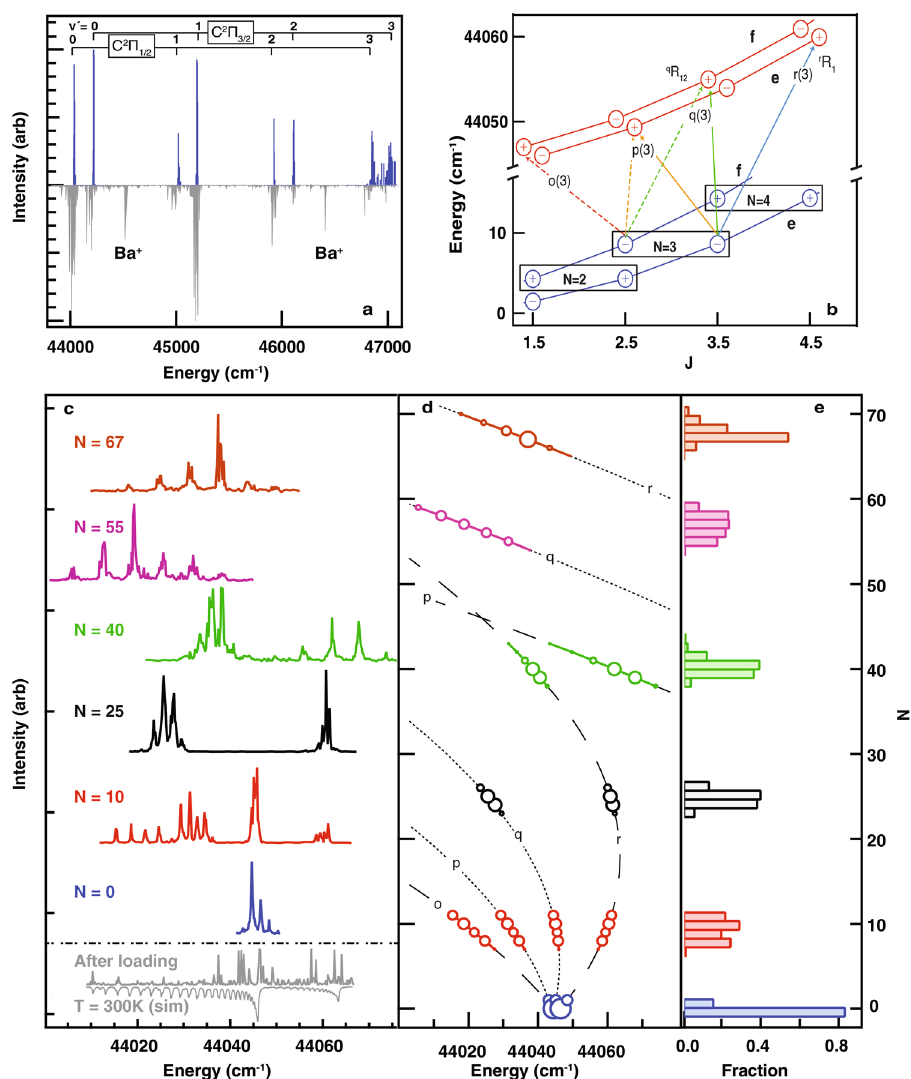
Fig. 2 Super rotor spectra. a Low-resolution survey spectrum of C 2 Π – X 2 Σ + transition of SiO + , before (lower) and after (upper) pumping toward N = 0. Two contaminating Ba + lines are present. The v ′ = 3 lines are expected to be broadened because of near-threshold predissociation, but these spectra are not yet fully understood. b Rotational fi ne structure of the C 2 Π 1/2 – X 2 Σ + transition (see Supplementary Information Section 1 for notation). c High- resolution spectra before and after pumping toward various N . The hot unpumped spectrum shows the sample is not yet thermalized to 300 K when pumping begins. d Fortrat diagram of the spectra, with marker areas proportional to deduced populations. Dashed and dotted lines are singly and doubly degenerate Fortrat parabolas. e Rotational populations corresponding to the